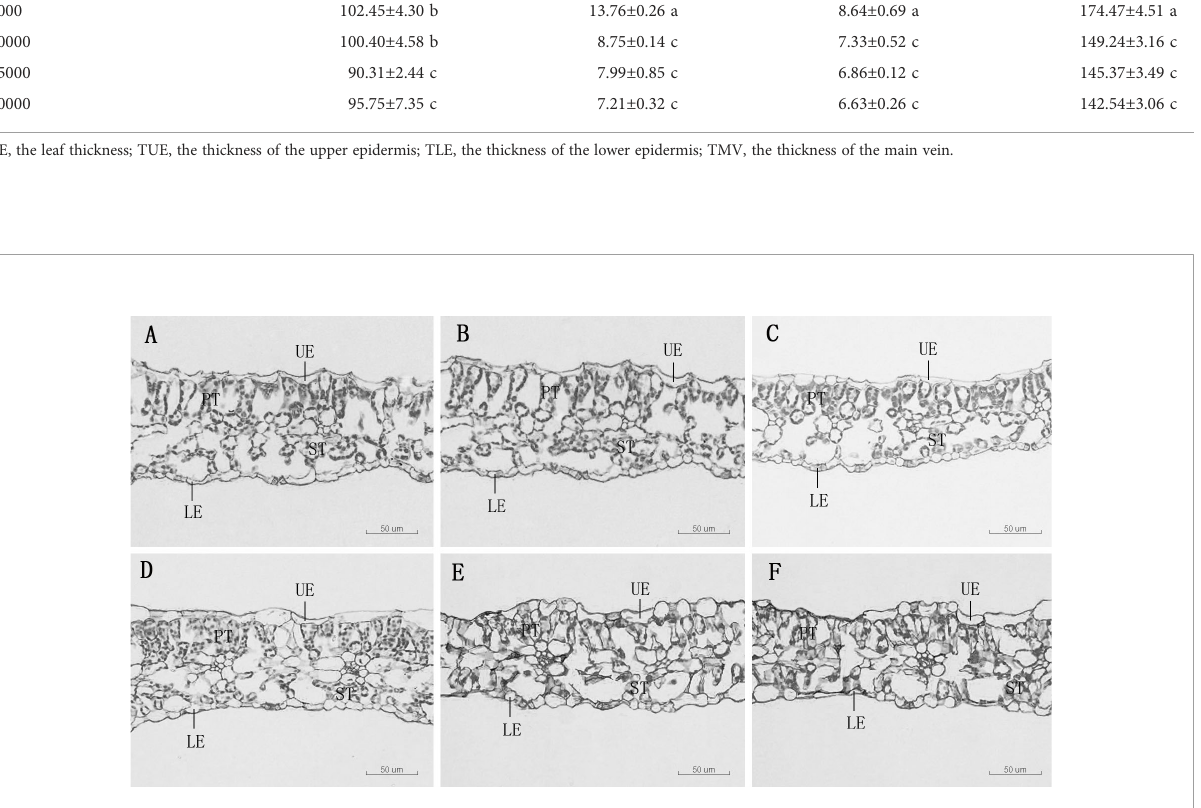
FIGURE 2 Leaf transverse anatomical structure of D. carota under Mn treatments (A – F) , UE, upper epidermis, LE, lower epidermis, PT, palisade tissue, ST, spongy tissue. (A) mdash;CK, (B) 1,000 µM, (C) 5,000 µM, (D) 10,000 µM, (E) 15,000 µM, (F) 20,000